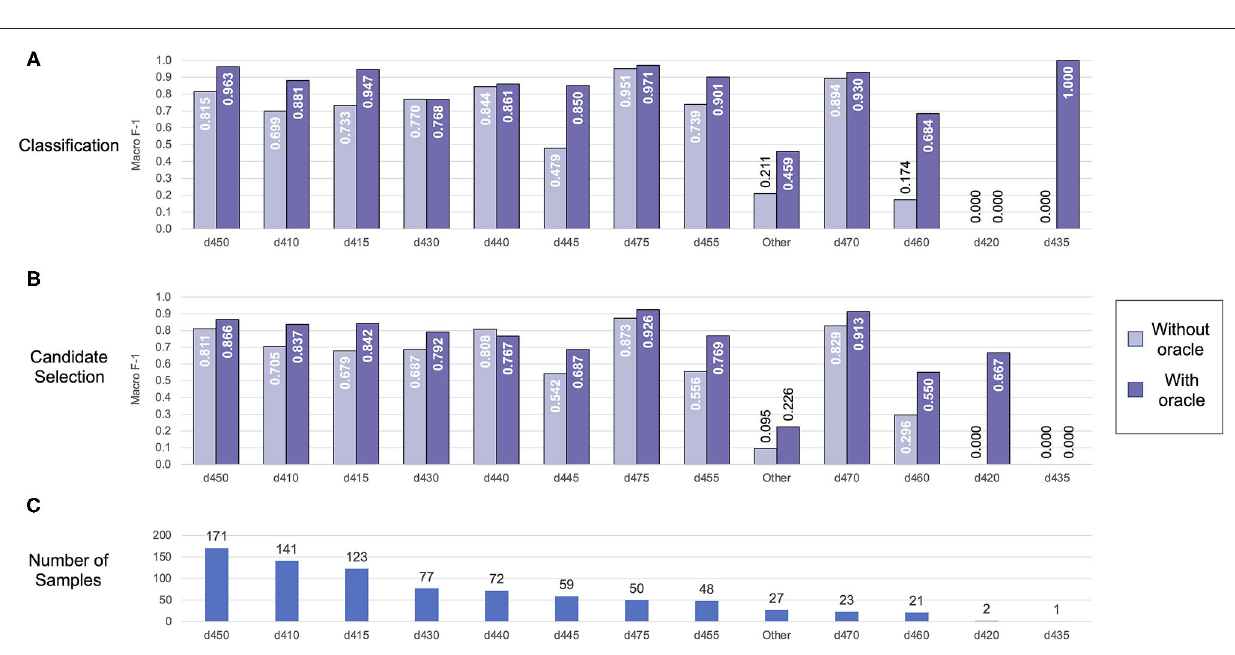
FIGURE 6 | Automated coding performance for each distinct category in the Mobility dataset. Classification results are shown in (A) , and candidate selection results in (B) . Categories are ordered by descending frequency [illustrated in (C)